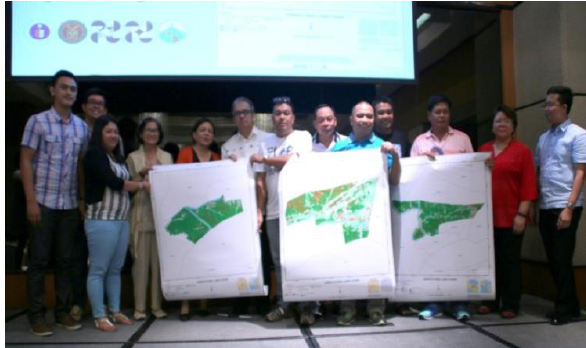
Figure 5. Turn-over of Phil-LiDAR 2 Agricultural Cover Maps to local government units